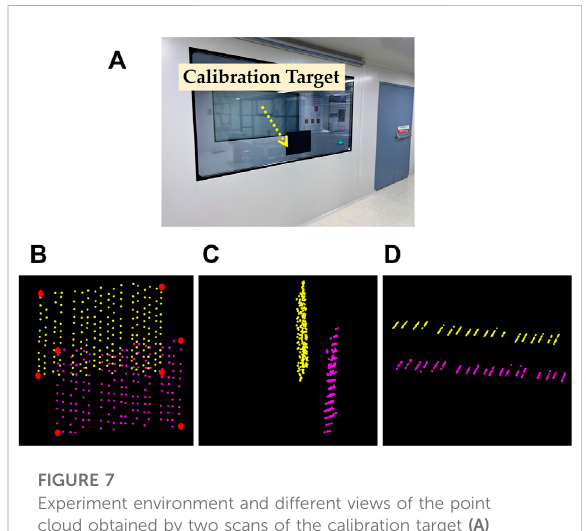
FIGURE 7 Experiment environment and different views of the